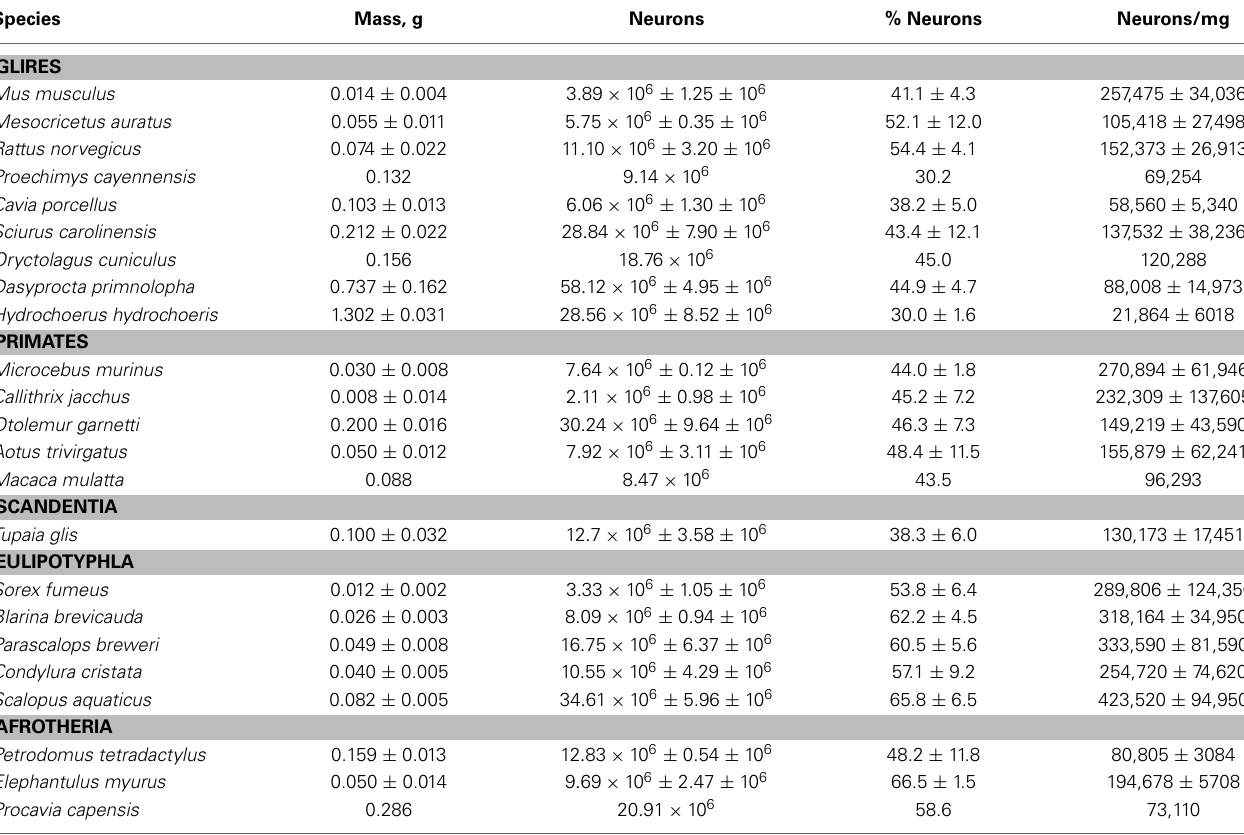
Table 1 | Cellular composition of the olfactory bulb. Species Mass,